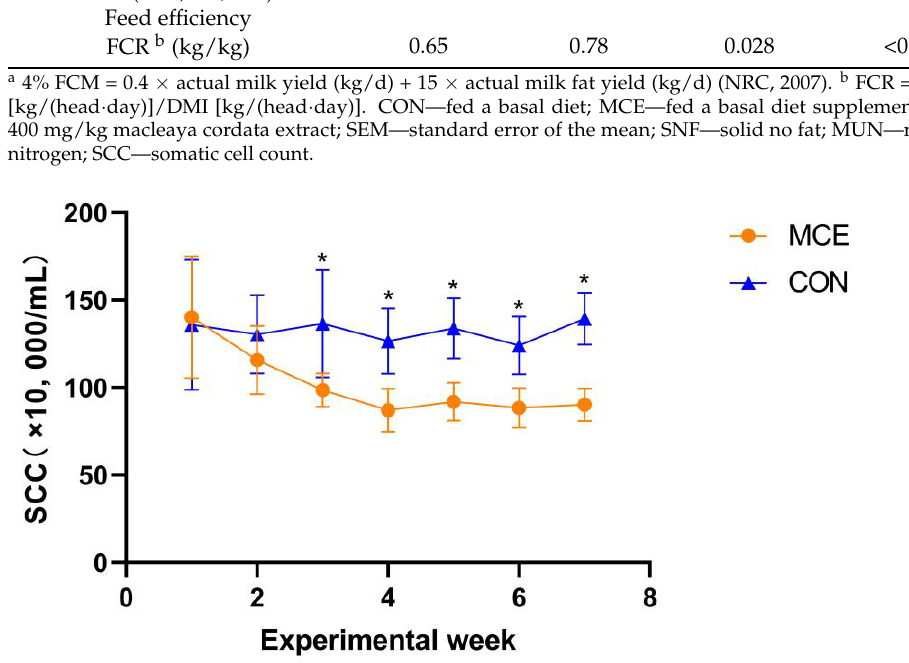
Figure 2. Change in average somatic cell count (SCC) throughout the study period in dairy goats. CON—fed a basal diet, MCE—fed a basal diet supplemented with 400 mg/kg macleaya cordata extract. Bars indicate the standard errors. * Superscripts indicate significant difference ( p < 0.05), while no-sign superscripts indicate no significant difference ( p > 0.05). Table 2. Effect of MCE on dry matter intake, milking performance, and milk composition.